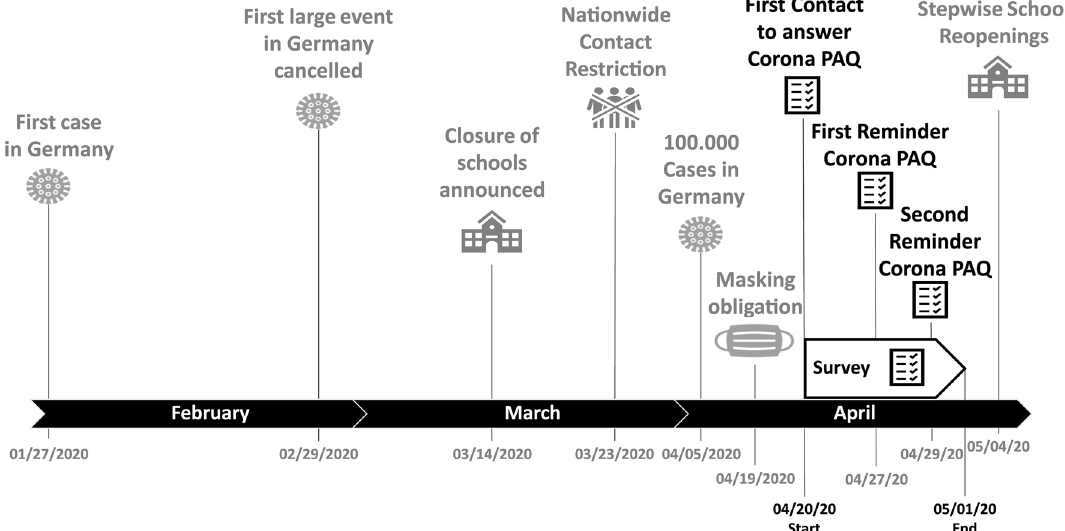
Figure 2. Timeline of events and survey context during the COVID-19 lockdown in